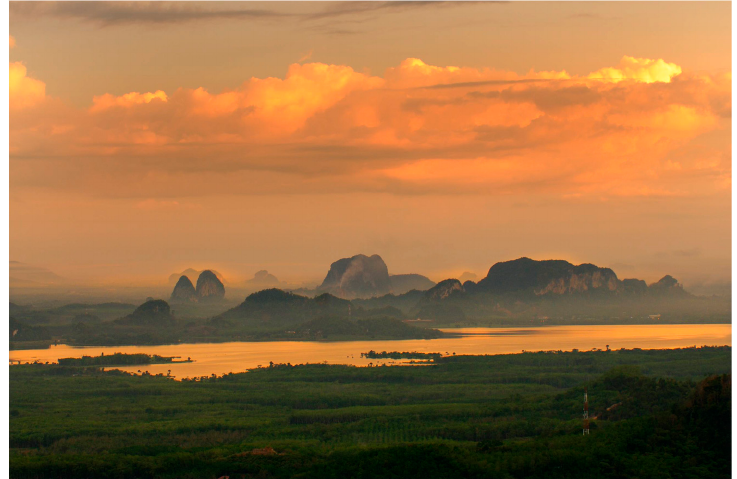
Figure 1. The Dragon Back karst formation in Perlis State, Peninsular Malaysia.